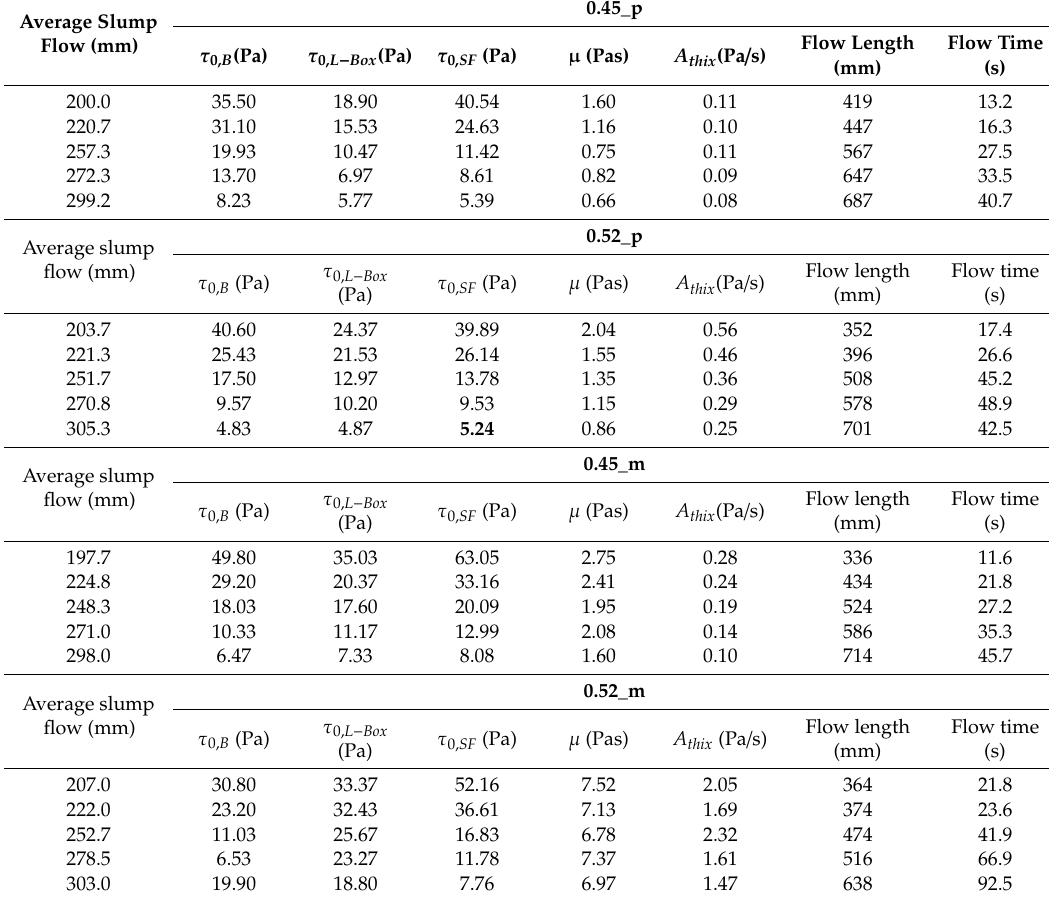
Table 2. Experimental results for all testing